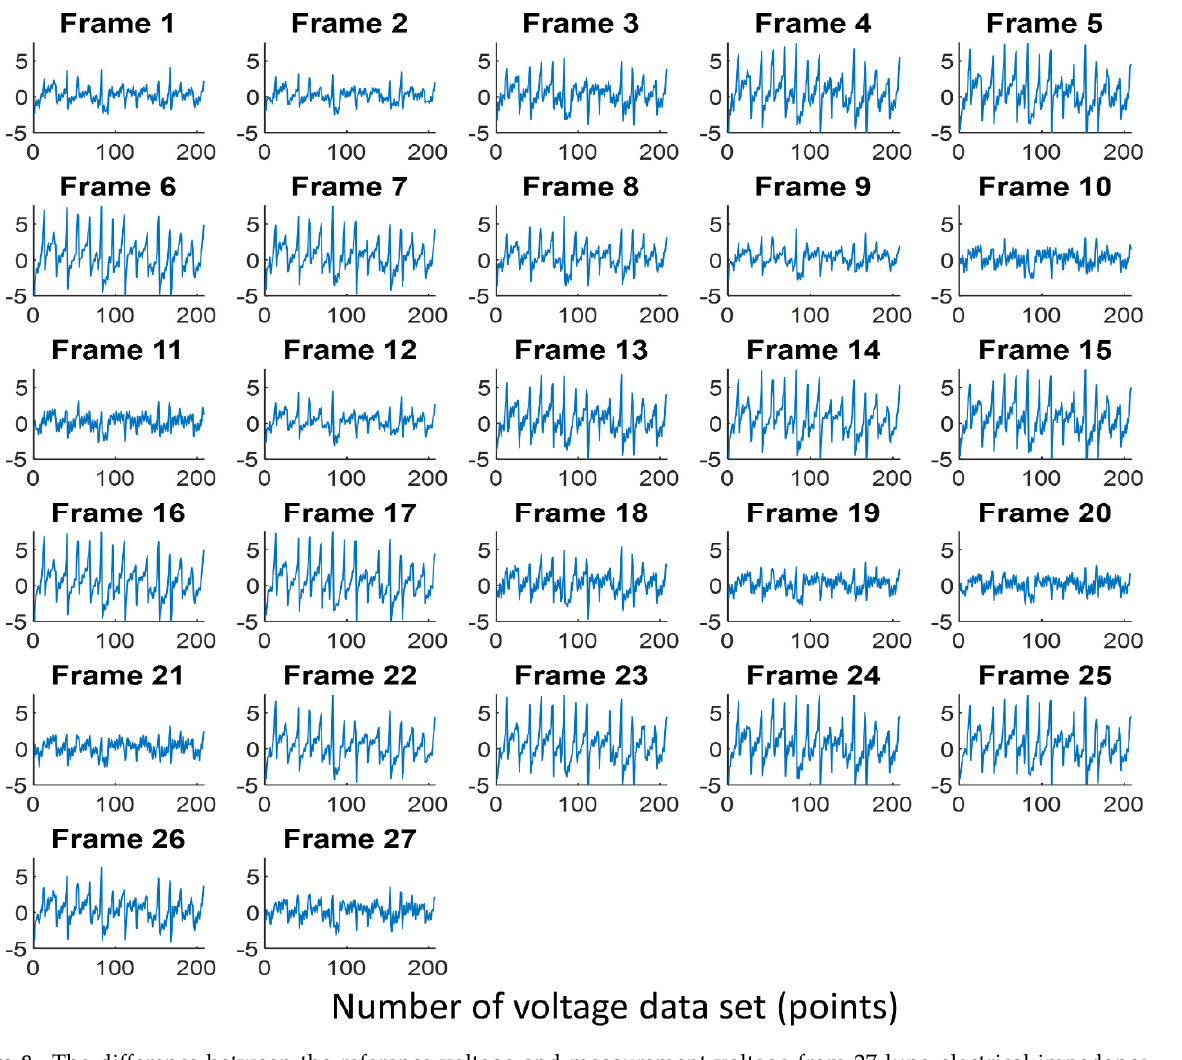
Figure 8. The difference between the reference voltage and measurement voltage from 27 lung electrical impedance tomography data using commercial electrocardiogram electrodes.